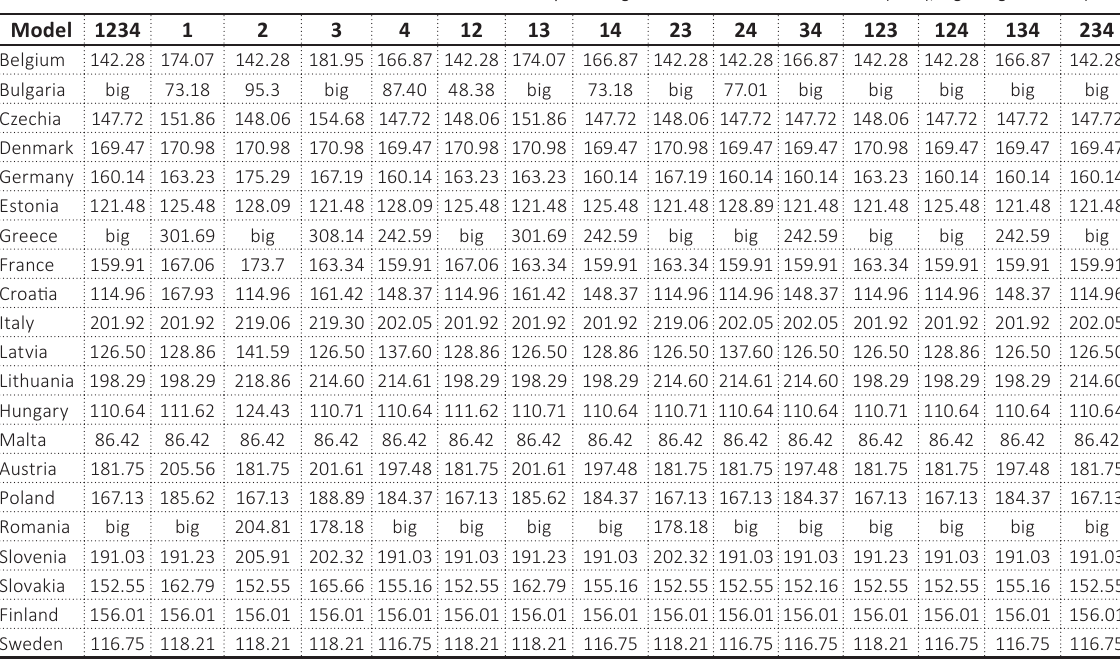
Table A2. Efficiency scores in fifteen output-oriented VRS models in